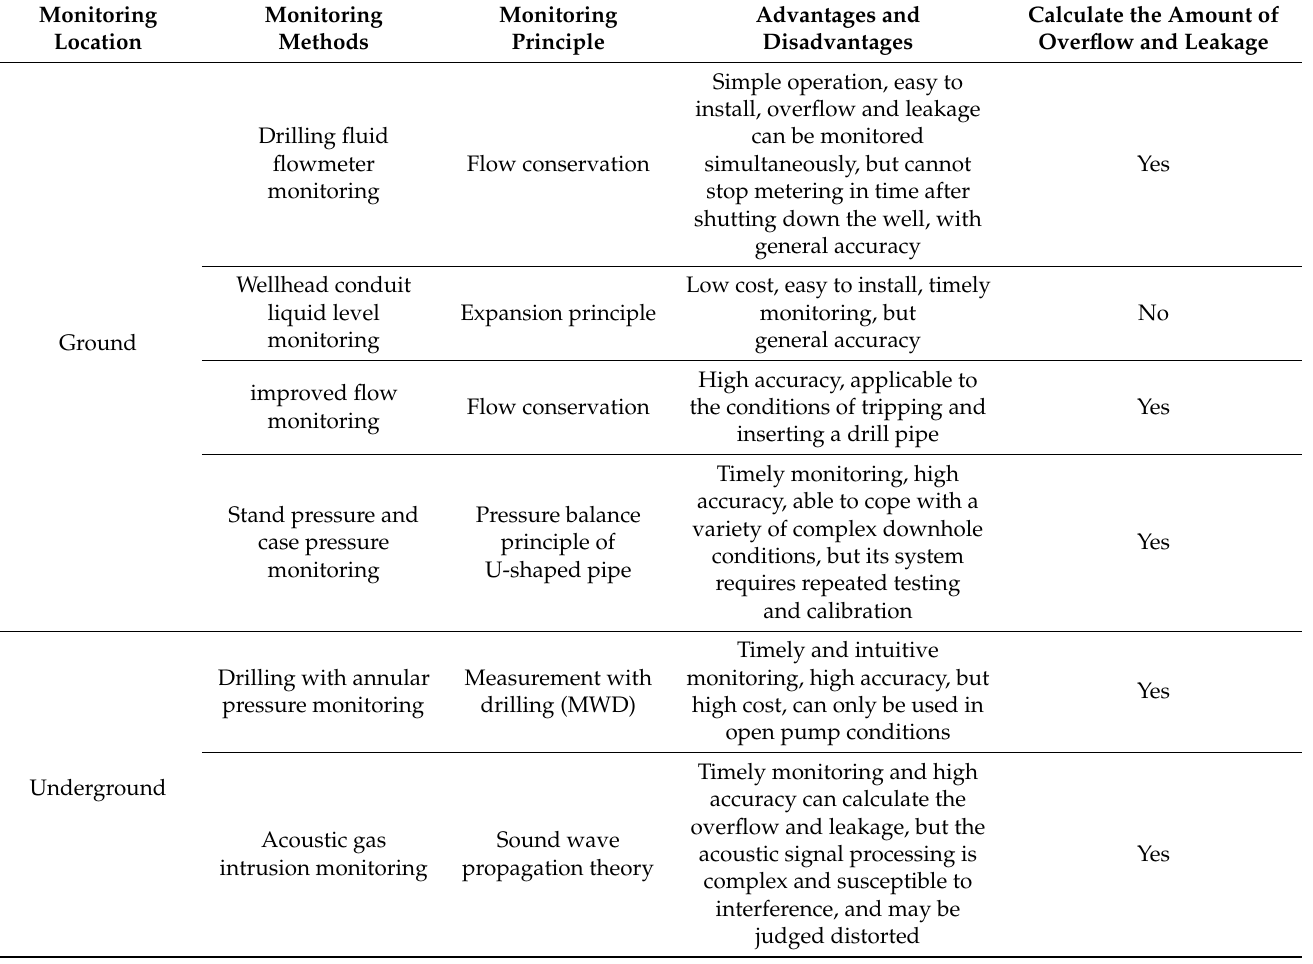
Table 1. Summary of early overflow and leakage detection